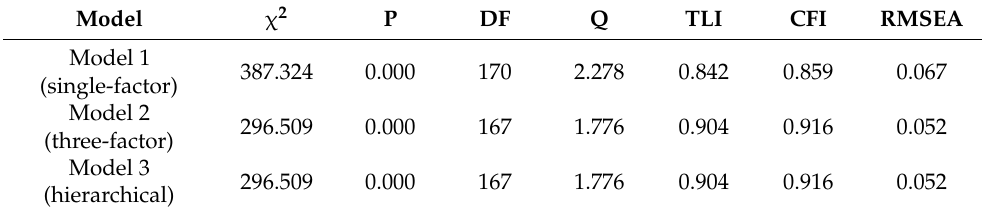
Table 3. Confirmatory factor analysis goodness-of-fit index.